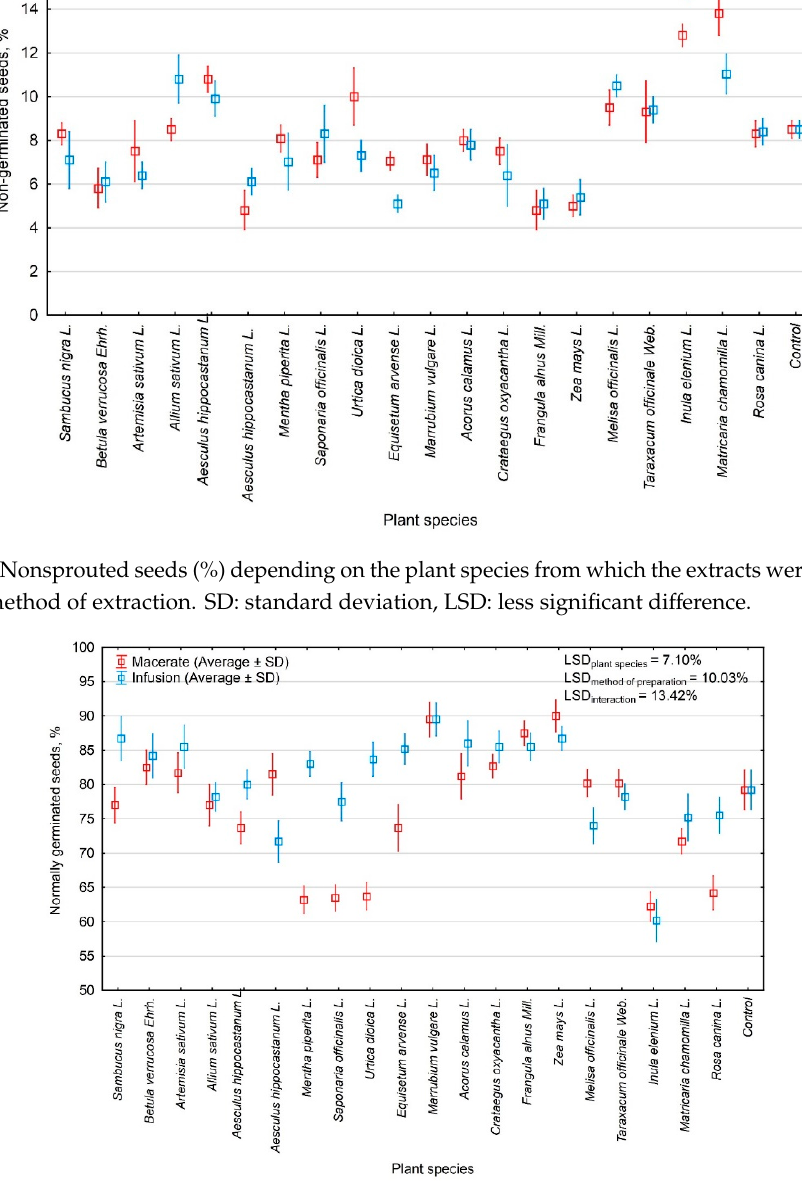
Figure 1. Nonsprouted seeds (%) depending on the plant species from which the extracts were obtained and the method of extraction. SD: standard deviation, LSD: less significant difference.